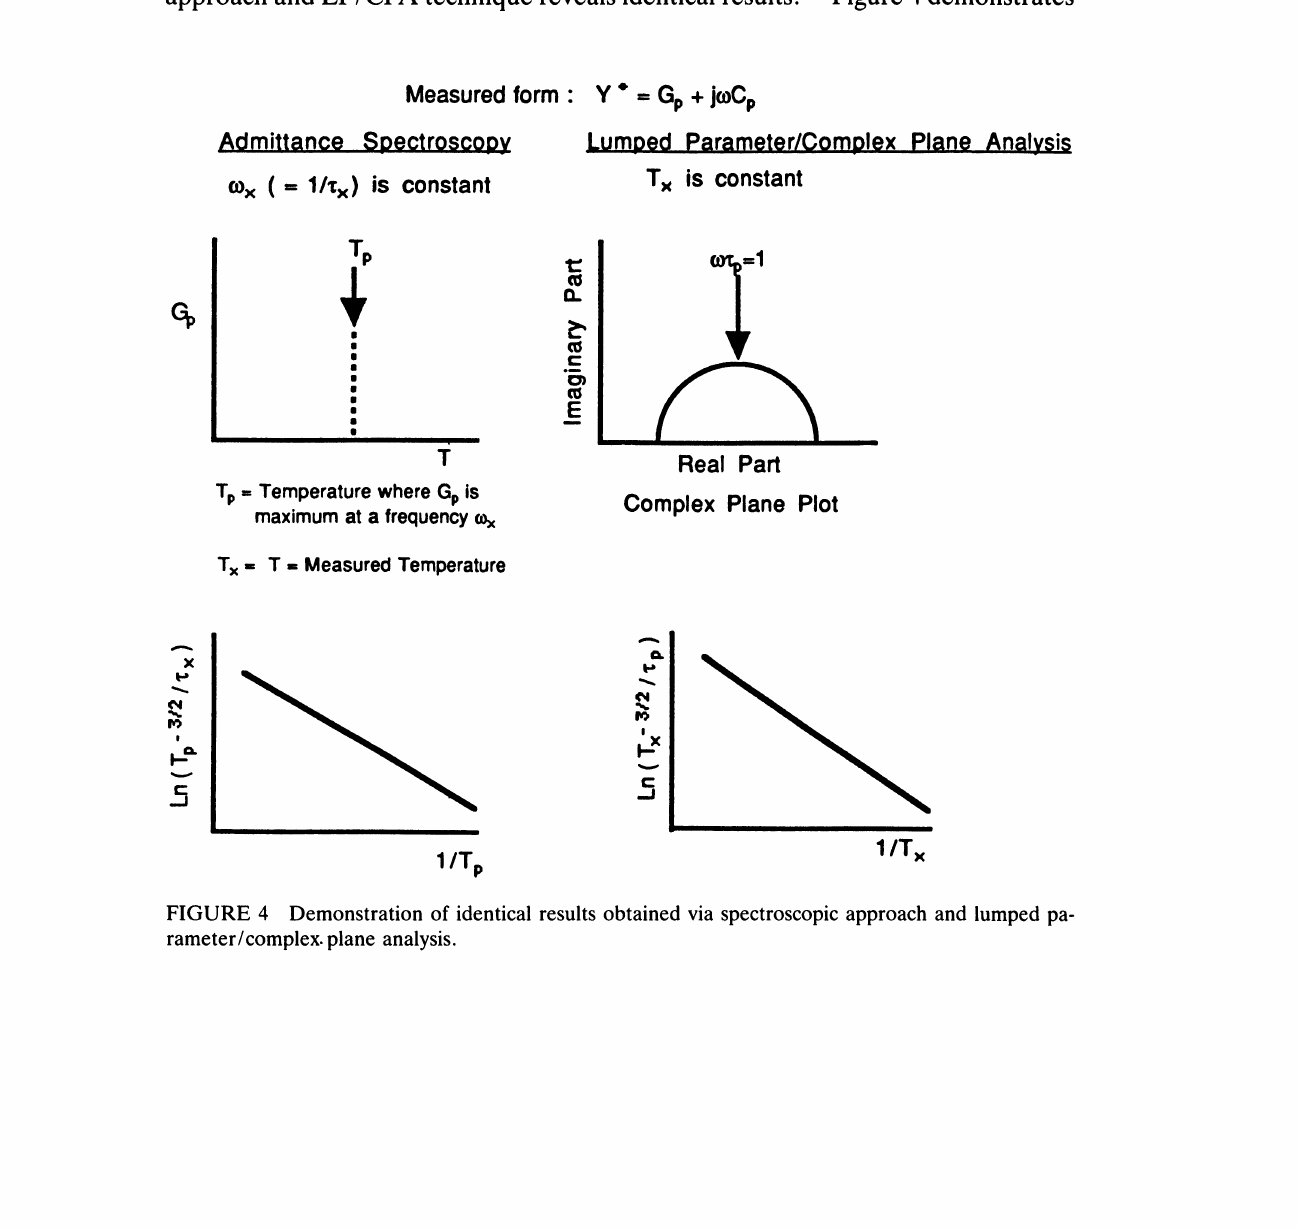
FIGURE 4 Demonstration of identical results obtained via spectroscopic approach and lumped pa- rameter/complex, plane